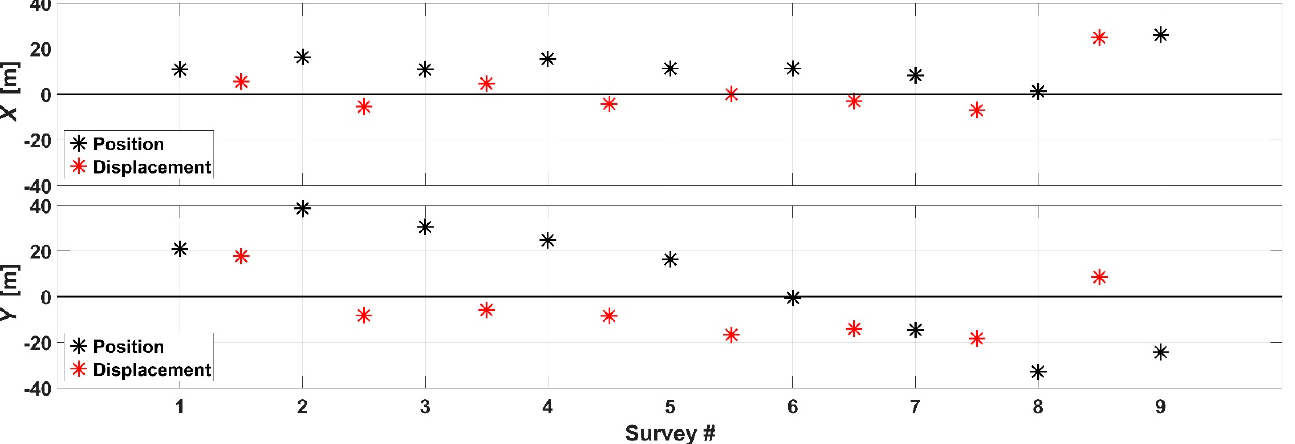
Figure 8. Position (black stars) of spit center of mass with respect to first survey minimum XY values, and displacement (red stars), which is the difference between each survey position. The position calculations were performed using accumulated weighted elevation (see Section 2.2) with X (upper panel) and Y (lower panel) coordinates. Black stars (position) show where the highest center of mass moves with respect to the first spit. Positive values represent east (in X) and north (in Y). For example, in the second survey, the spit center of mass moves to the east (positive X value in the upper panel) and to the north (positive Y value in the lower panel).